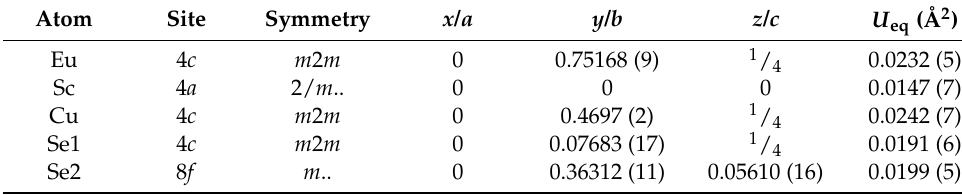
Table 2. Fractional atomic coordinates of EuScCuSe 3